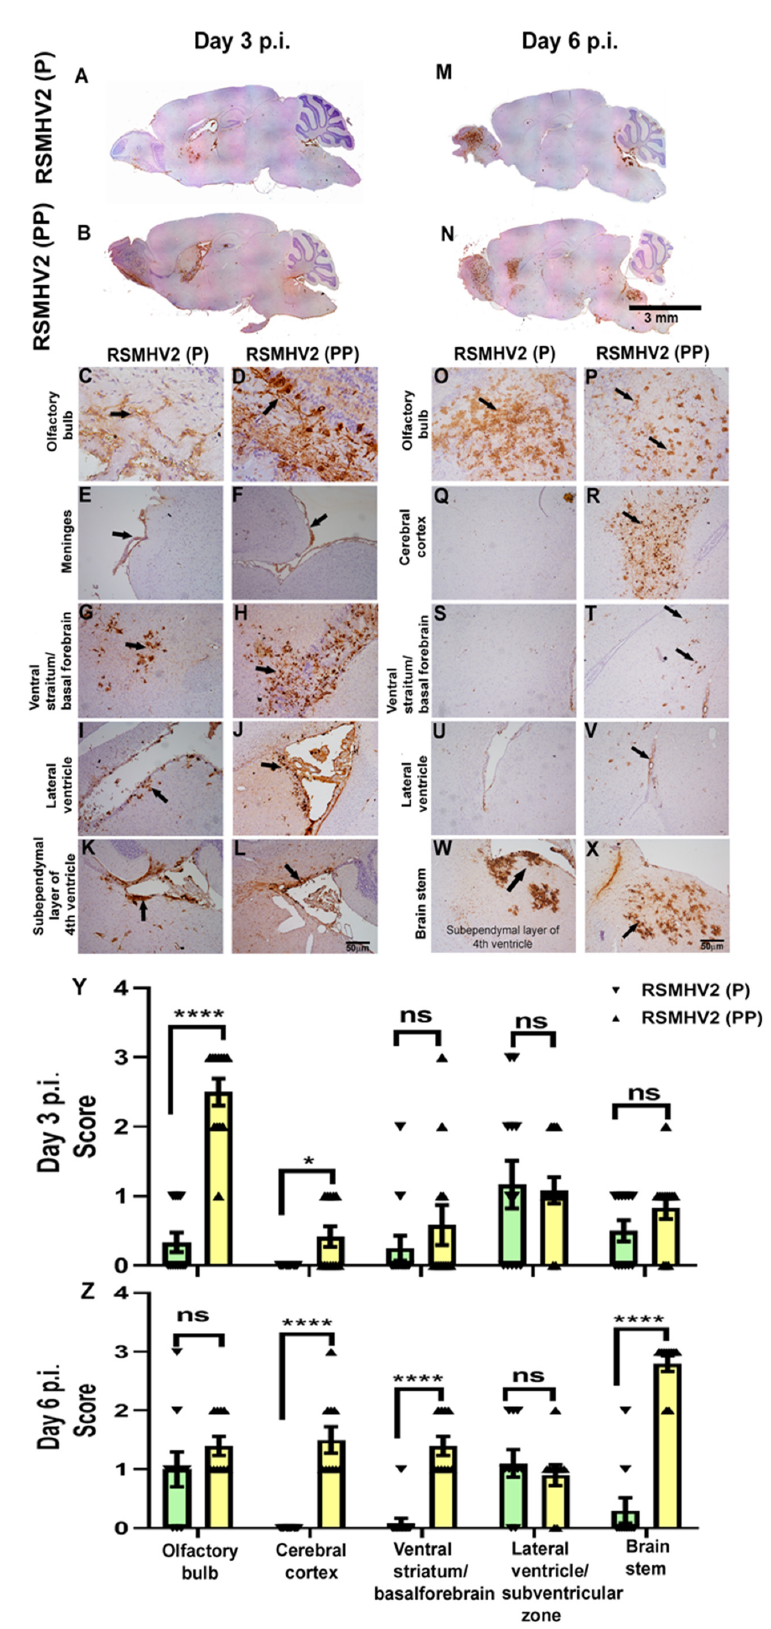
Figure 6. Differential distribution of viral antigen in different neuroanatomical regions from RSMHV2 (P) and RSMHV2 (PP) at days 3 and 6 p.i. brains . Five-micron thick mid-sagittal